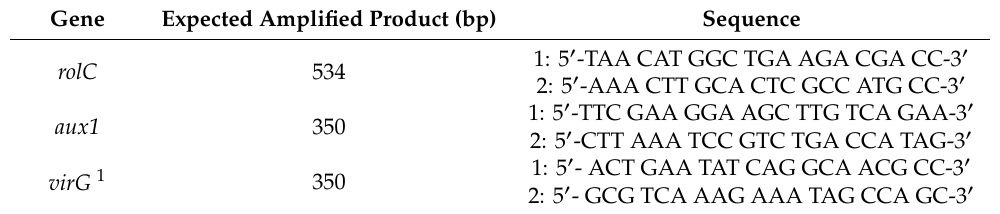
Table 3. Specific pairs of primers used for PCR analysis of transformed roots of Helianthella quinquenervis. Gene Expected Amplified Product